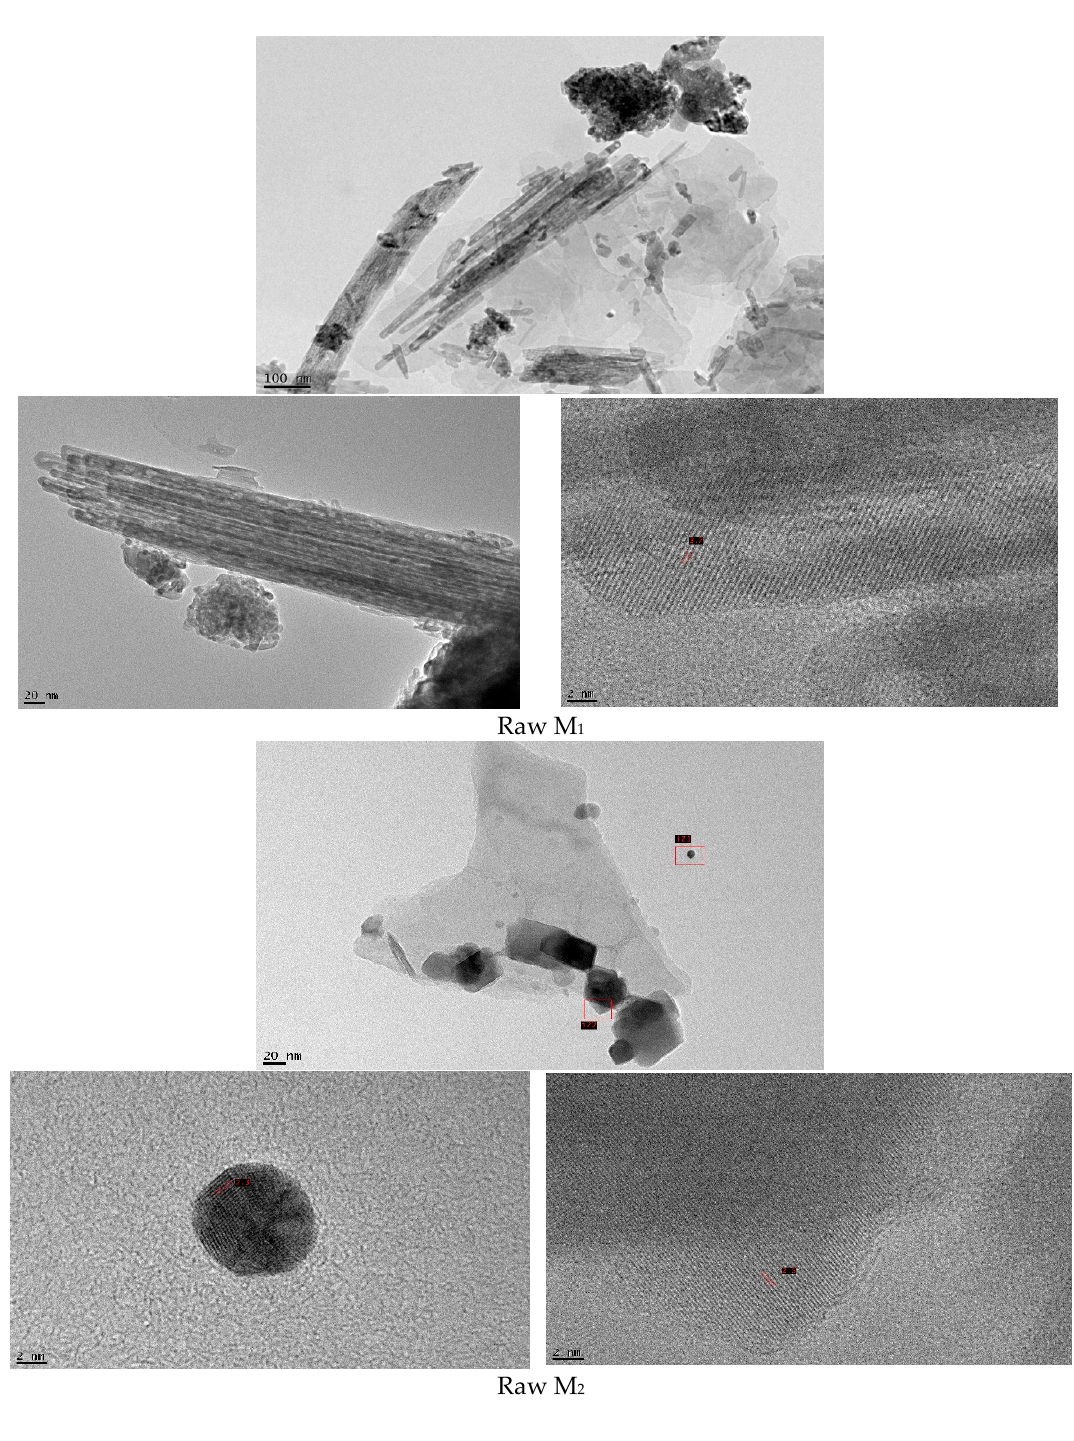
Figure 7. TEM images for the raw materials M 1 and M 2 .